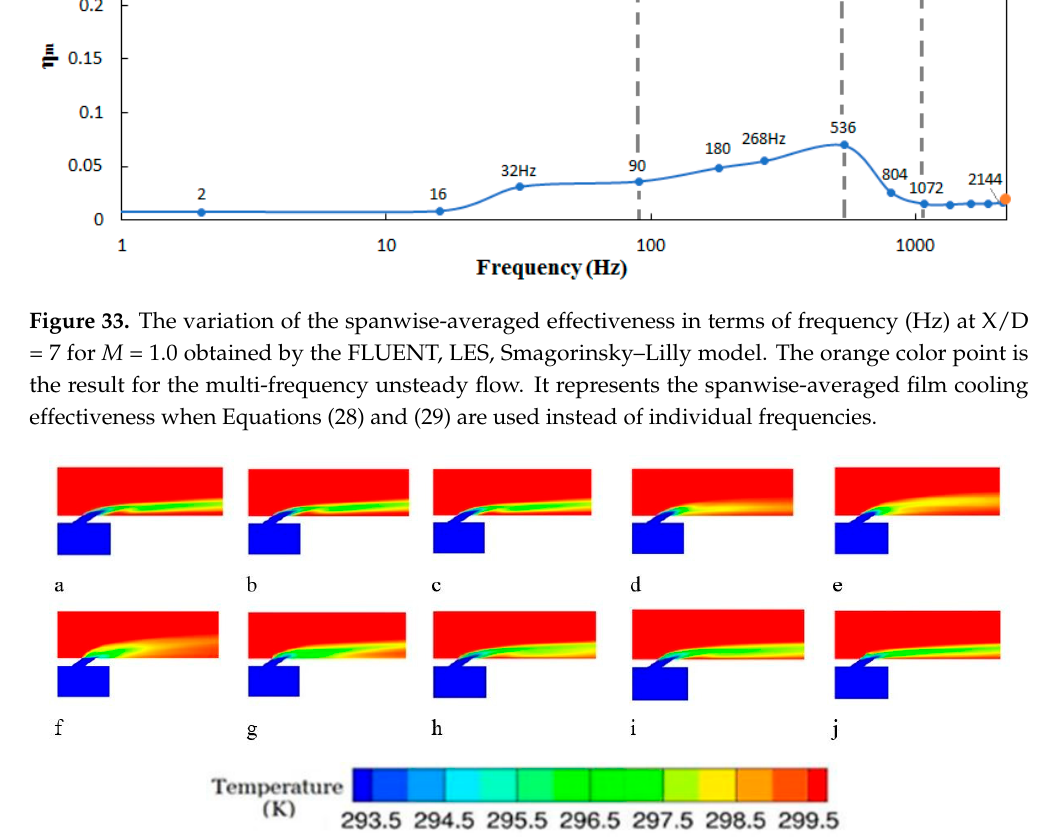
Figure 34. ( a ) The mean temperature contours for the central cross section using the FLUENT, LES, Smagorinsky–Lilly model for M = 1.0, 0 Hz. ( b ) The mean temperature contours for the central cross section using the FLUENT, LES, Smagorinsky–Lilly model for M = 1.0, 2 Hz. ( c ) The mean temperature contours for the central cross section using the FLUENT, LES, Smagorinsky–Lilly model for M = 1.0, 16 Hz. ( d ) The mean temperature contours for the central cross section using the FLUENT, LES, Smagorinsky–Lilly model for M = 1.0, 32 Hz. ( e ) The mean temperature contours for the central cross section using the FLUENT, LES, Smagorinsky–Lilly model for M = 1.0, 90 Hz. ( f ) The mean temperature contour for the central cross section using the FLUENT, LES, Smagorinsky–Lilly model for M = 1.0, 268 Hz. ( g ) The mean temperature contour for the central cross section using the FLUENT, LES, Smagorinsky–Lilly model for M = 1.0, 536 Hz. ( h ) The mean temperature contour for the central cross section using the FLUENT, LES, Smagorinsky–Lilly model for M = 1.0,1072 Hz. ( i ) The mean temperature contour for the central cross section using the FLUENT, LES, Smagorinsky–Lilly model for M = 1.0, 1608 Hz. ( j ) The mean temperature contour for the central cross section using the FLUENT, LES, Smagorinsky–Lilly model for M = 1.0, 2144